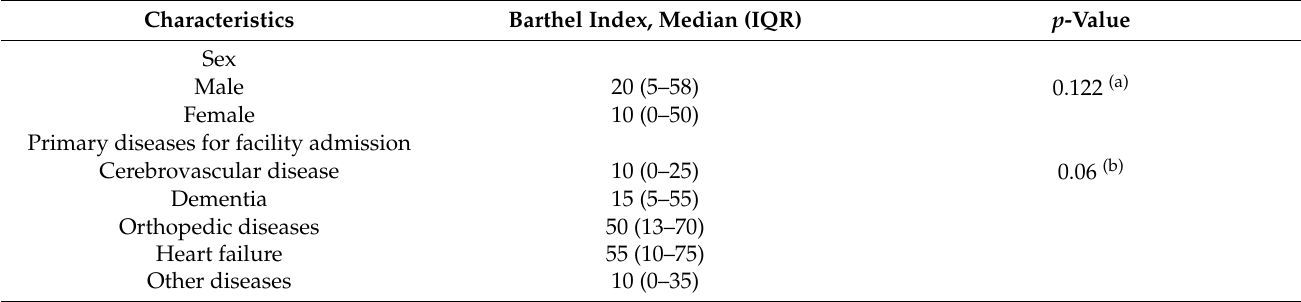
Table 3. Univariate analysis of the Barthel index.